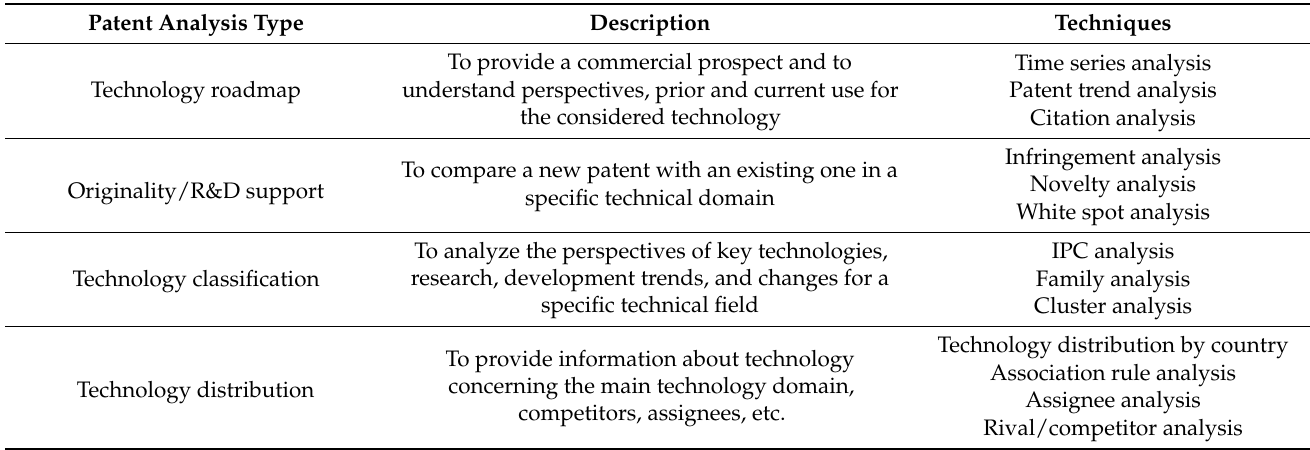
Table 2. Summary of patent analysis types (authors’ elaboration from Mehrotra et al.